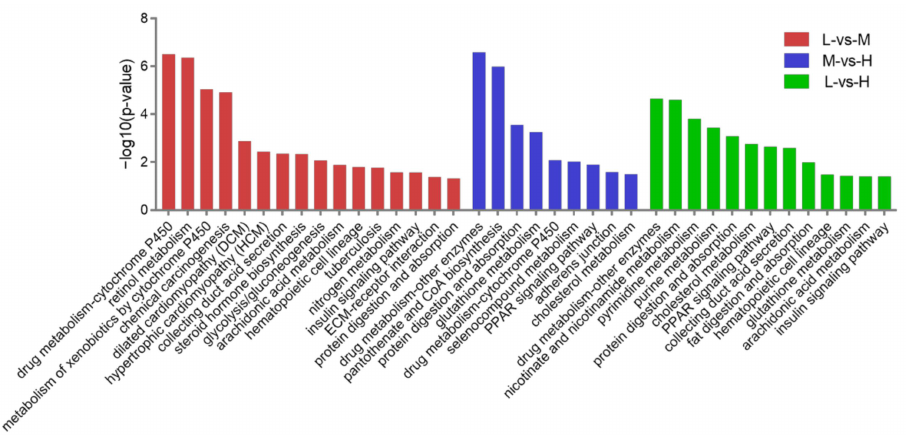
Figure 10. Kyoto Encyclopedia of Genes and Genomes (KEGG) pathway analysis. A portion of the significantly enriched pathways are shown, when comparing the DEPs between L-vs-M, M-vs-H, and